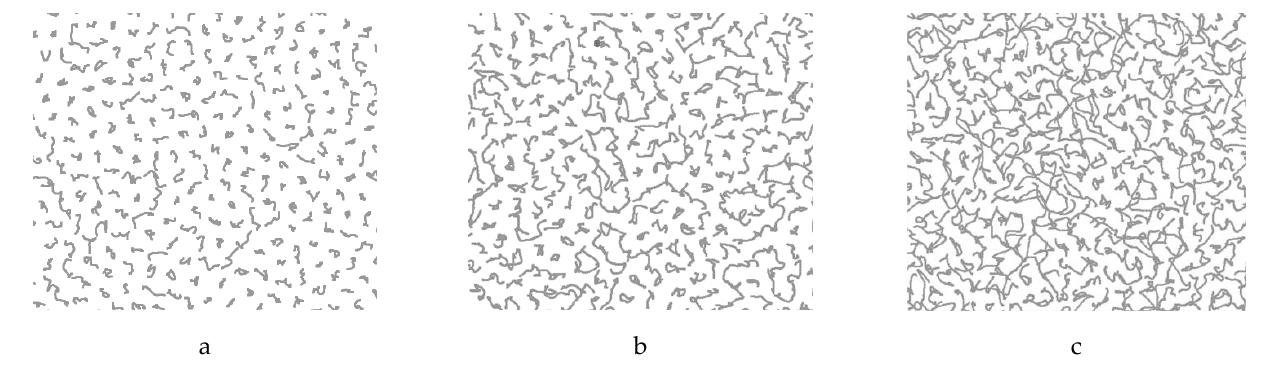
Figure 2. Particle trajectories in 0.3 s. Initial Г* 0 = 300, ( a ) 𝐹̅ = 10 fN ; ( b ) 𝐹̅ = 20 fN ; ( c ) 𝐹̅ = 40 fN .